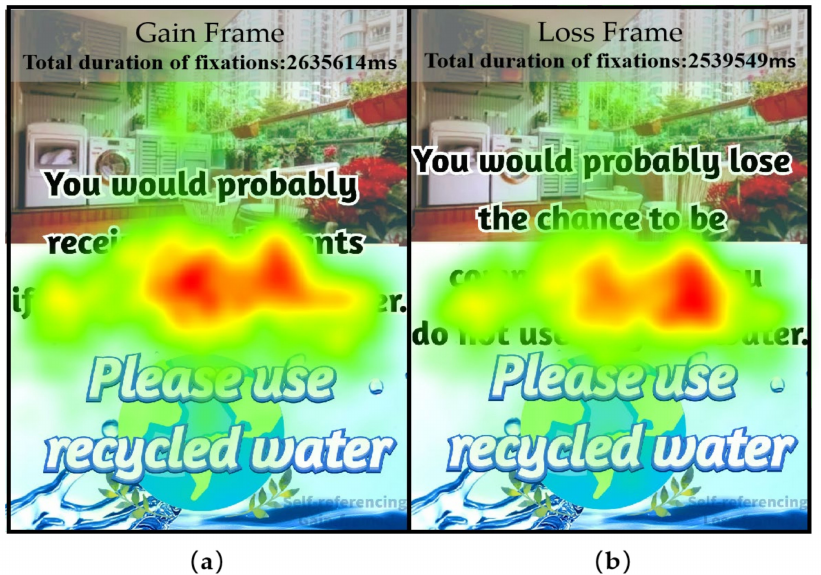
Figure 4. Eye-tracking heat map of posters with different message frames. ( a ) Eye-tracking heat map of gain frame; ( b ) Eye-tracking heat map of loss frame.